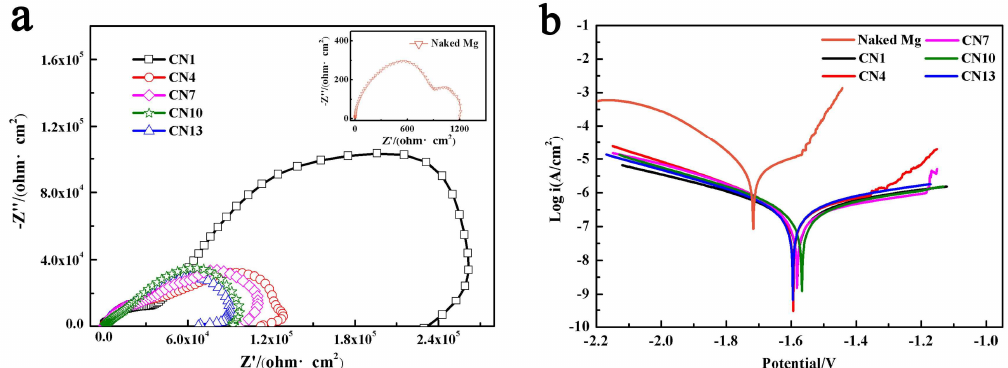
Figure 6. Electrochemical properties of the naked Mg alloy and different Ca-P-coated samples in SBF solution: ( a ) Nyquist plots; ( b ) potentiodynamic polarization curves. Table 2. Electrochemical properties of the naked Mg alloy and different Ca-P-coated samples. Samples